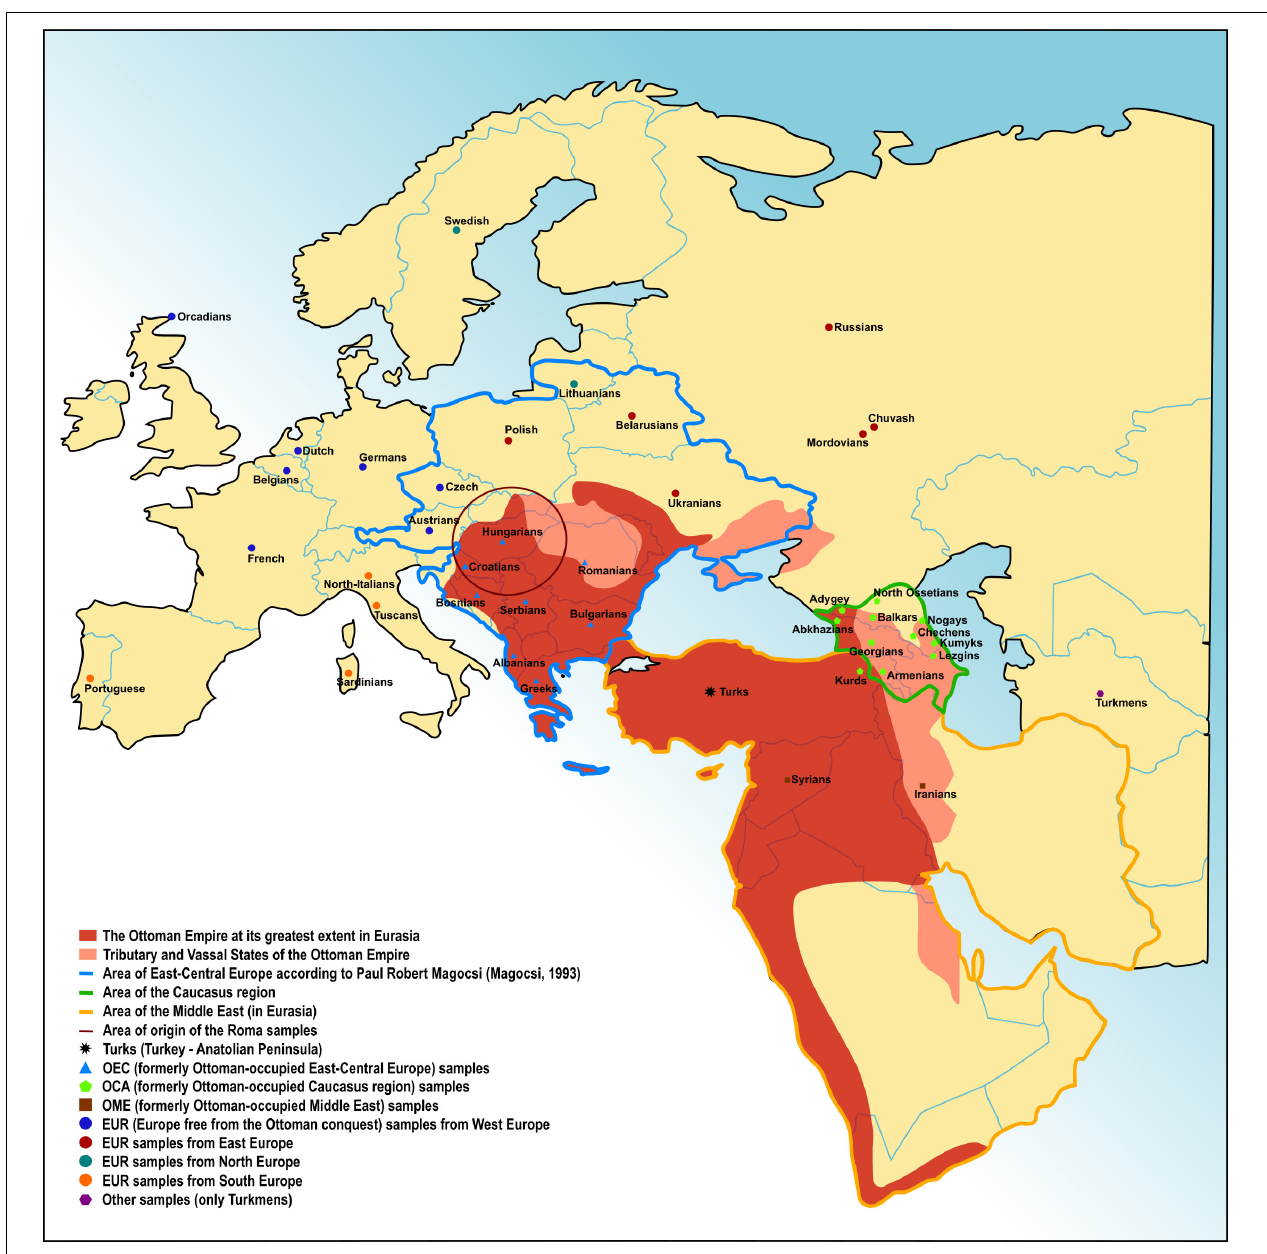
FIGURE 1 | The Ottoman Empire in Eurasia. Territory of the Ottoman Empire at its greatest extent, tributary and vassal states of the Empire. Investigated regions and ethnic groups are also